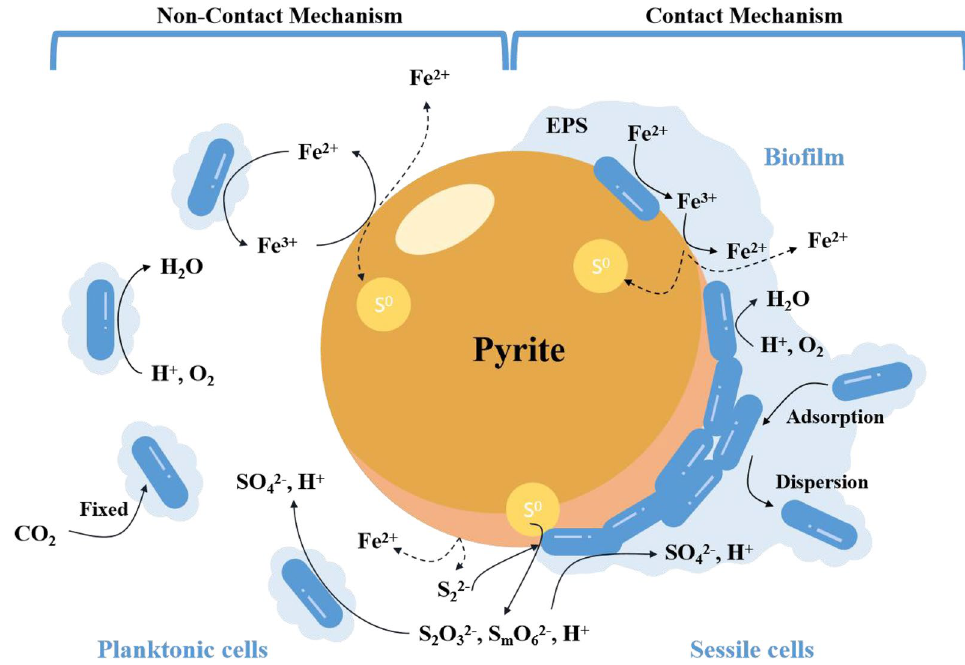
Fig. 4 Bioleaching performance by contact and non-contact microbial